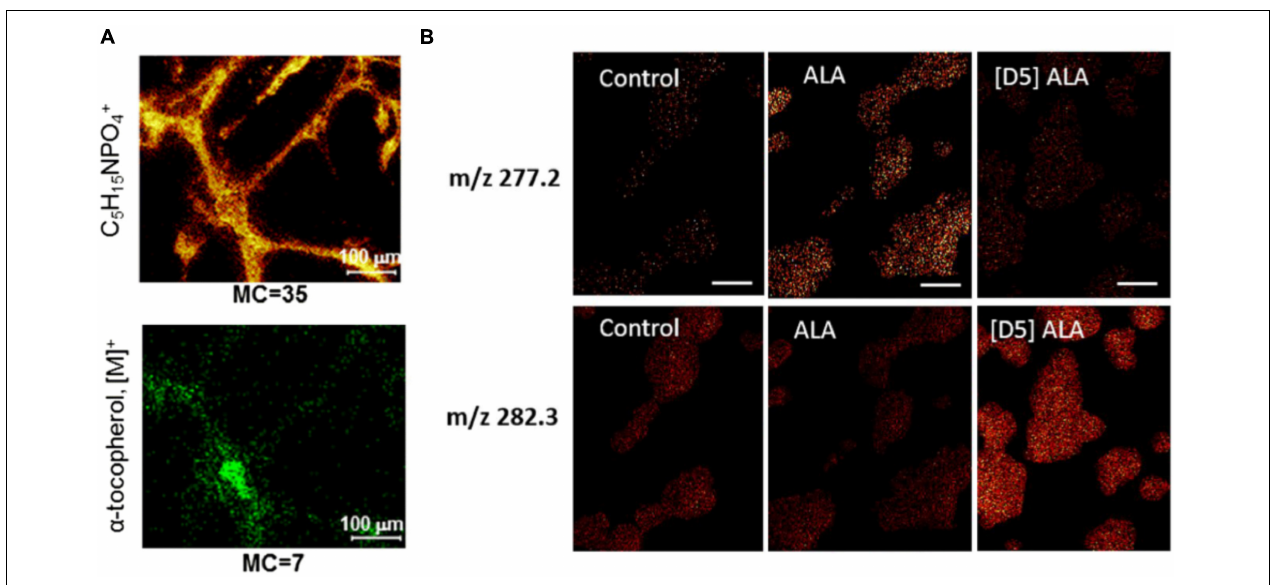
FIGURE 3 | Examples of ToF-SIMS imaging in nerve cells. (A) Ion images of phosphocholine head group C 5 H 15 PO 4 + and α -tocopherol of human iPSC-derived neurons. (B) Ion images of masses m/z 277.2 and m/z 282.3 of PC12 cells incubated with α -linolenic acid (ALA) and isotopically labeled D 5 -ALA. ALA-incubated cells show higher signal in m/z 277.2 than in 282.3, whereas for D 5 -ALA the signal of incubated cells in m/z 282.3 is more dominant because of the contribution of the isotopic label. The Figures were reproduced and modified from Bruinen et al. (2018) and Philipsen et al. (2018) under the creative commons